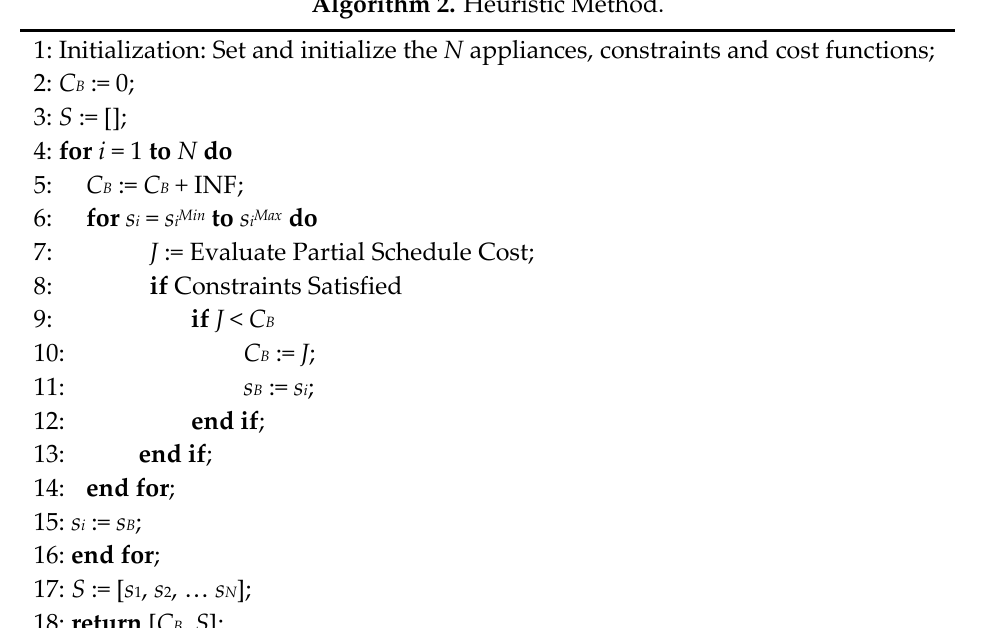
Algorithm 2. Heuristic Method.